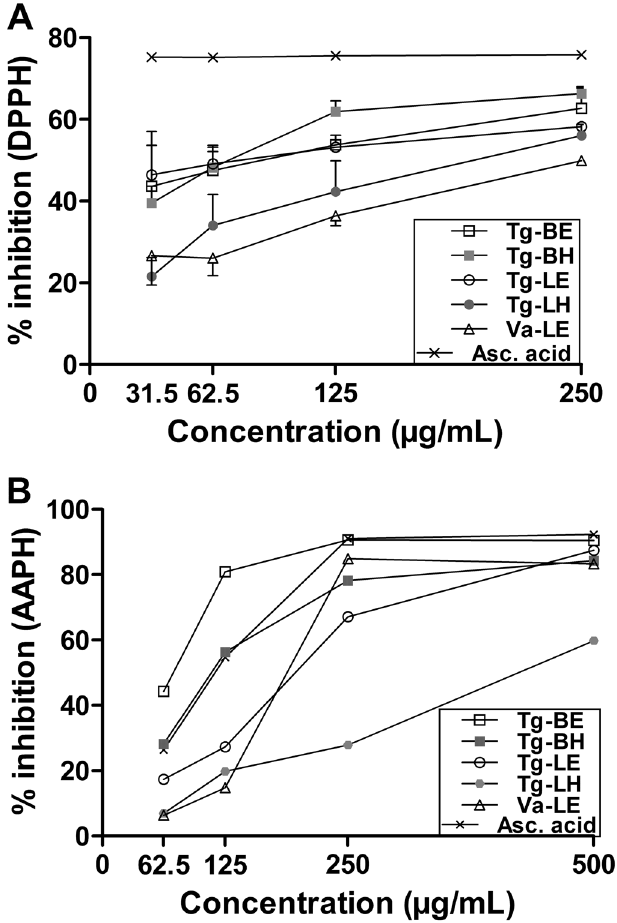
Figure 1. Anti-oxidantactivityoftheplantextractsevaluatedby the DPPH (A) and the AAPH (B) assays. Values of the DPPH assayaremeans+or (cid:3)